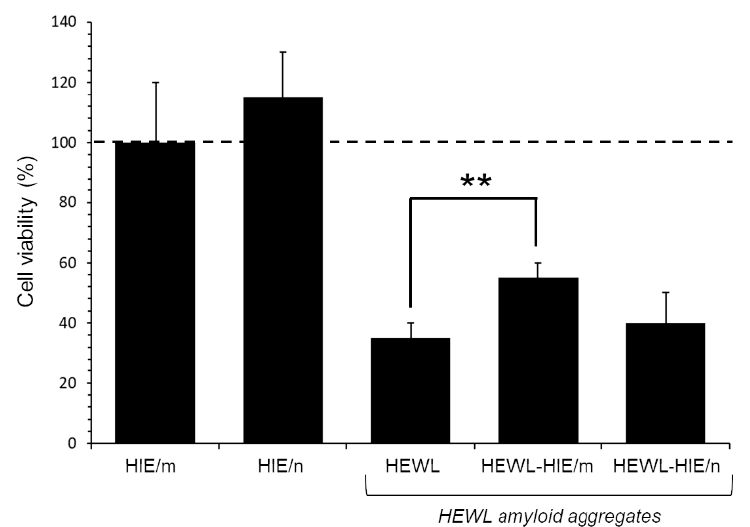
Figure 5. Effect of HIEs on cytotoxicity induced by HEWL aggregates on SH-SY5Y cells. Cells were treated for 48 h with HEWL aggregates formed for 4 days in the absence or presence of HIE / m or HIE / n. Data are reported as percentage values with respect to the untreated control cells (represented by the dotted line) and expressed as the mean ± standard deviation of at least three independent experiments of three independent extractions. Error bars represent standard deviations. Statistical significance was performed using T-test: **: p -Value < 0.01 vs. the untreated control